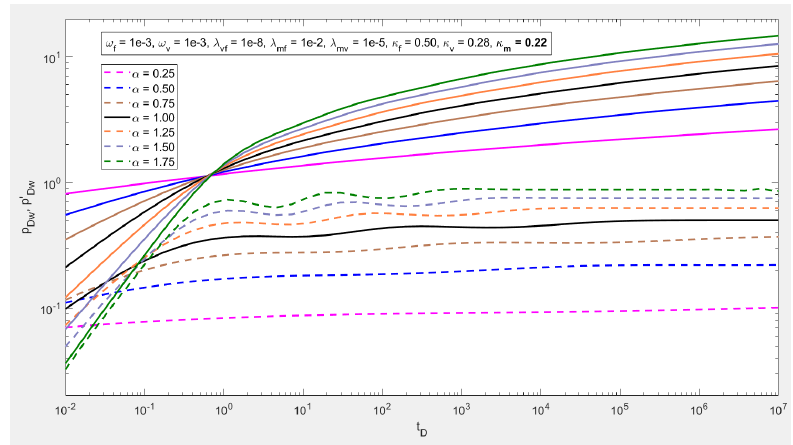
Figure 6. Effects of varying the order on the fractional time derivative considering α = α f = α v = α m .